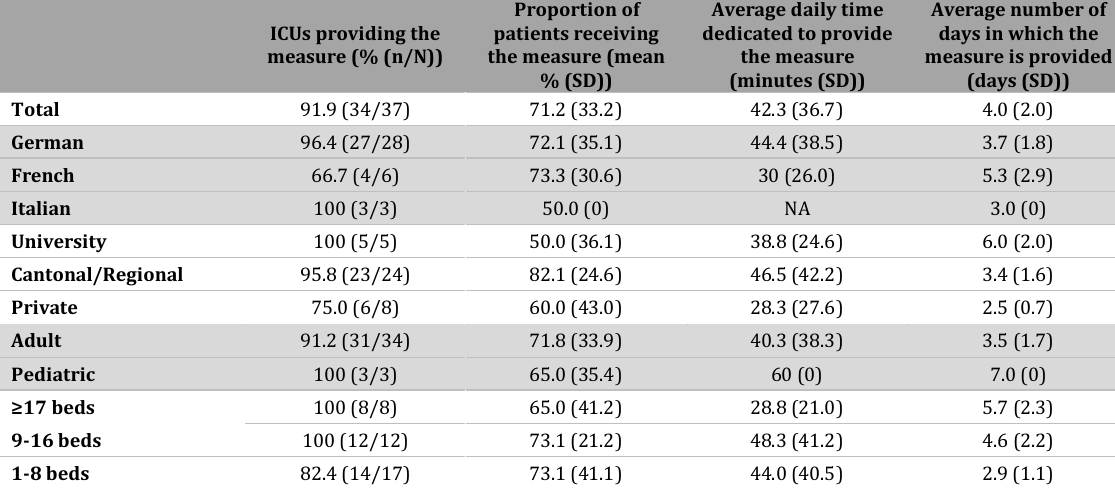
Table S10. Active side to side turning